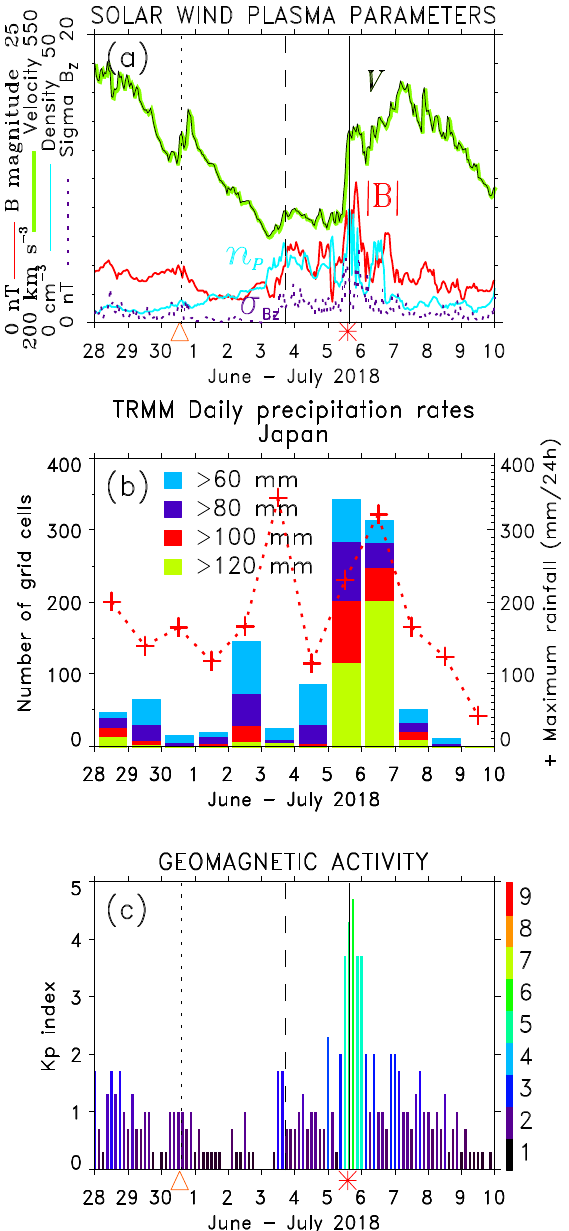
Figure 2. ( a ) Solar wind plasma parameters, ( b ) the number of TRMM grids with daily rainfall exceeding given thresholds and the maximum daily precipitation (red crosses), and ( c ) geomagnetic activity Kp -index. Vertical lines mark CIR (solid), HCS (dashed) and ICME (dotted). HSS/CIRs and ICMEs are marked by red asterisks and orange triangles, respectively.